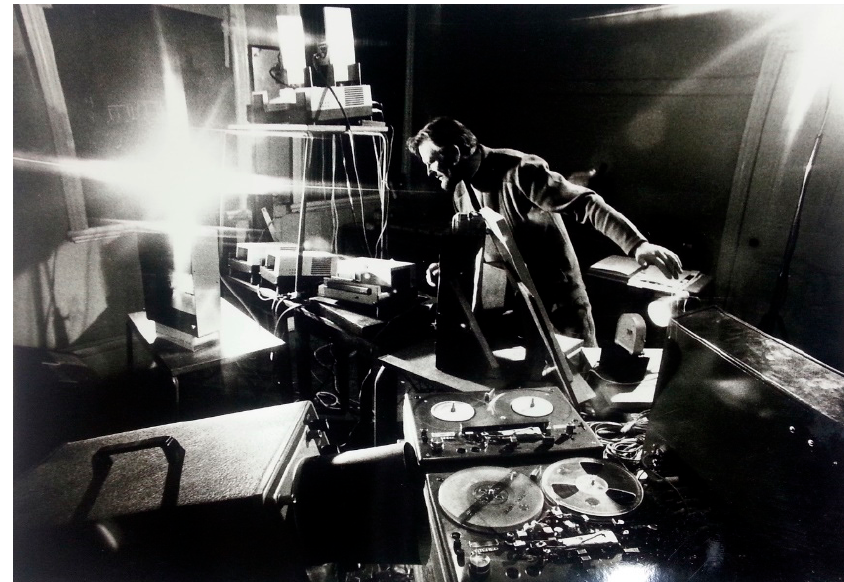
Figure 28. Composited landscape with CGI slide, dated February 1993. SLSA: PRG919/22/2140. Image courtesy Maria Garda. Published with permission of SLSA.